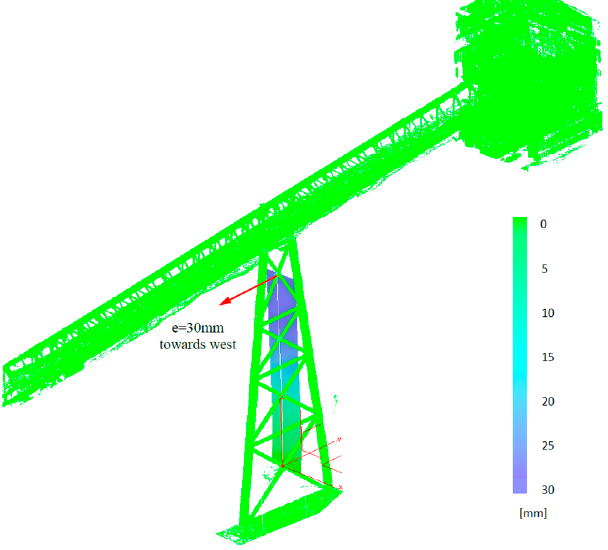
Figure 13. 3D scan of the structure.